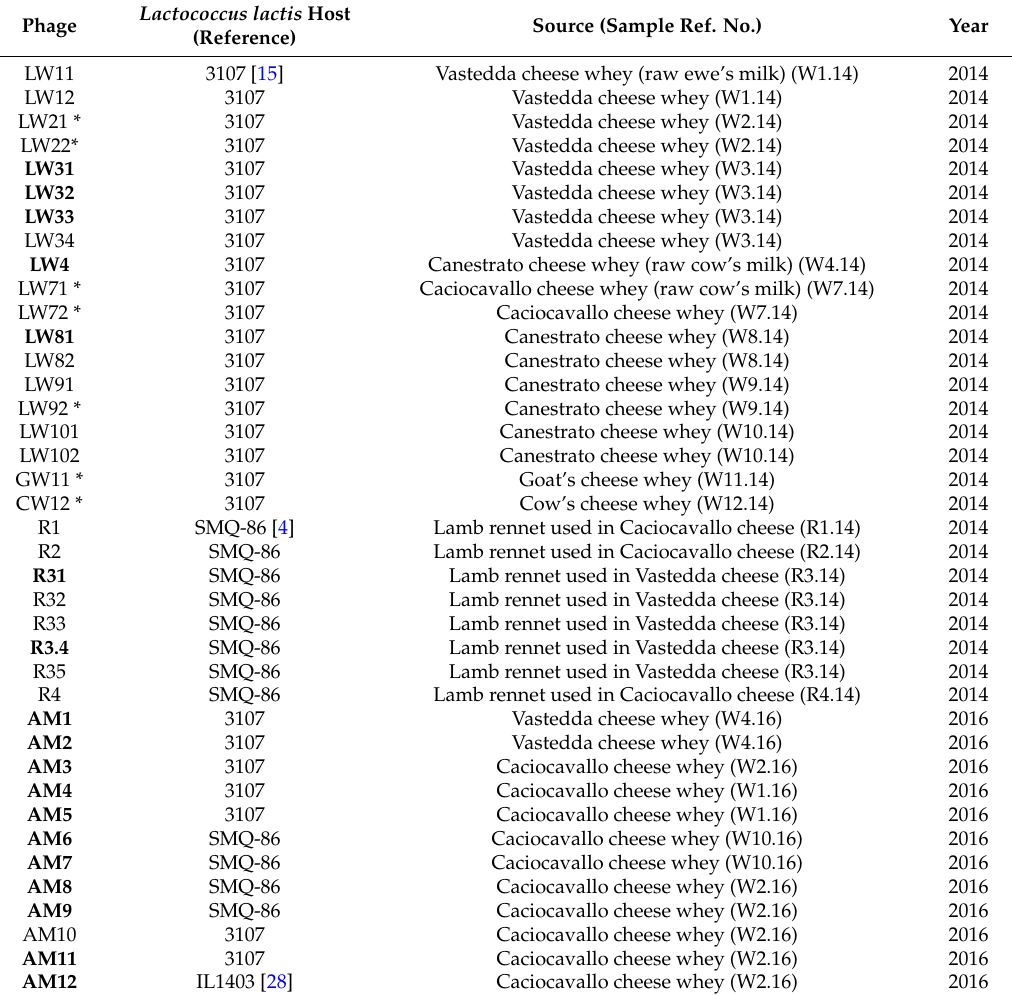
Table 1. Phages isolated in this